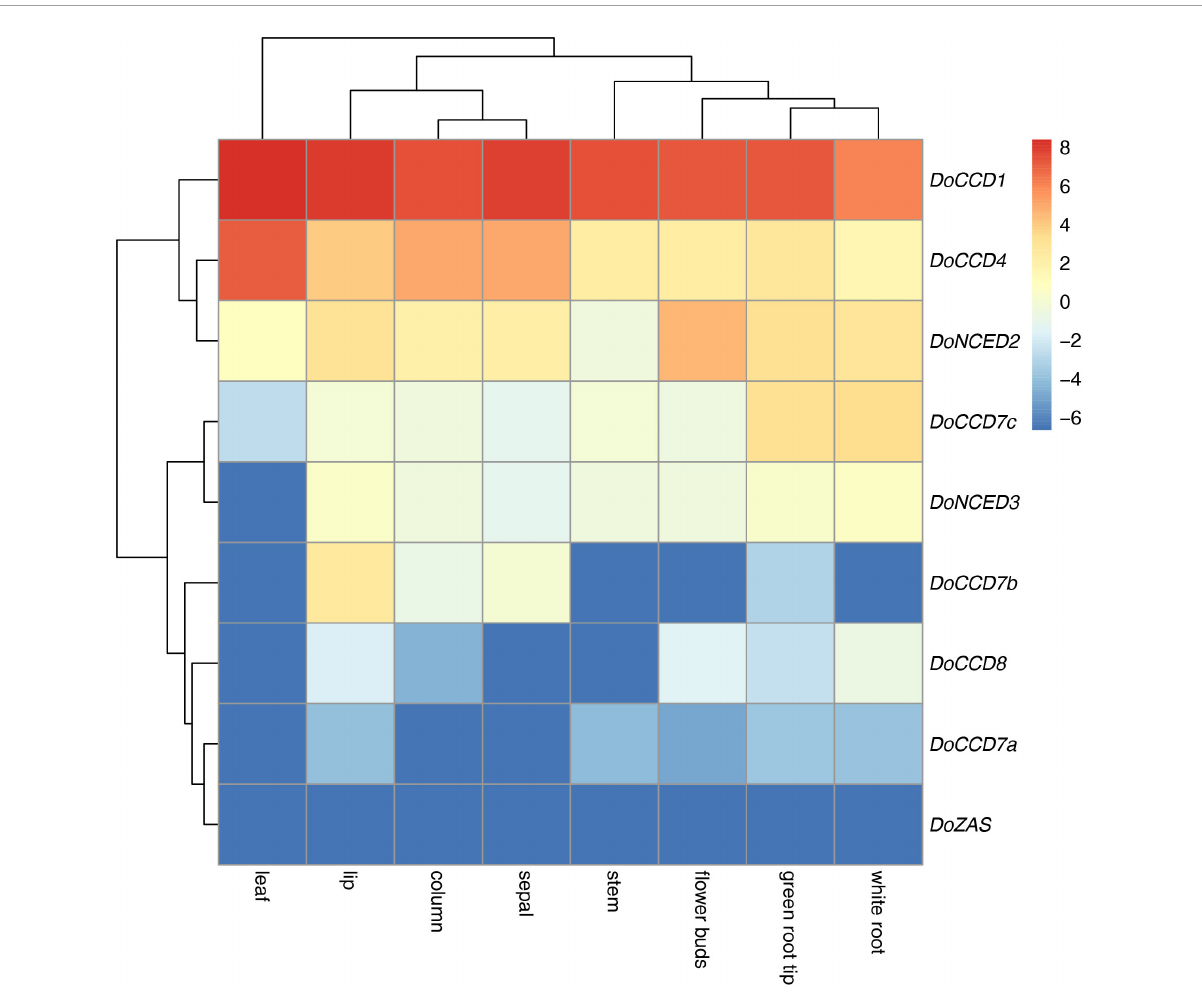
FIGURE4 Expression heatmap of nine DoCCD genes in eight tissues. The data was from the RNA-Seq (Zhang et al., 2017) including tissues such as column, flower buds, lip, sepal, leaf, stem, white root, and green root tip. R package was used to construct the heatmap and the color scale stands for the normalized